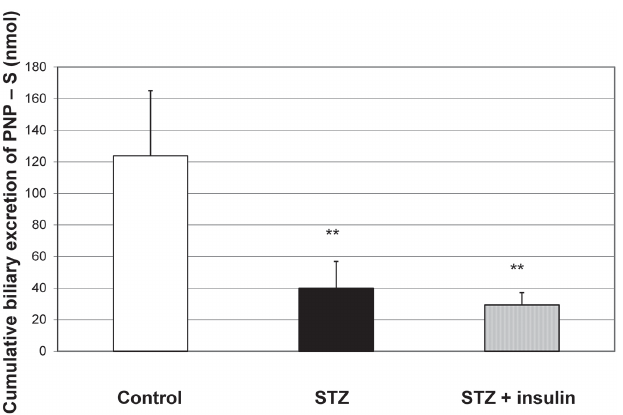
FIGURE 4 - Cumulative biliary excretion of PNP-S after the 90- min luminal perfusion of 500 µM PNP in control and diabetic rats without or with insulin administration. Data represent the mean of ± S.E. of seven rats. Significant difference from the control value: ** p<0.01. No significant difference was found between the values of STZ-diabetic rats without or with insulin